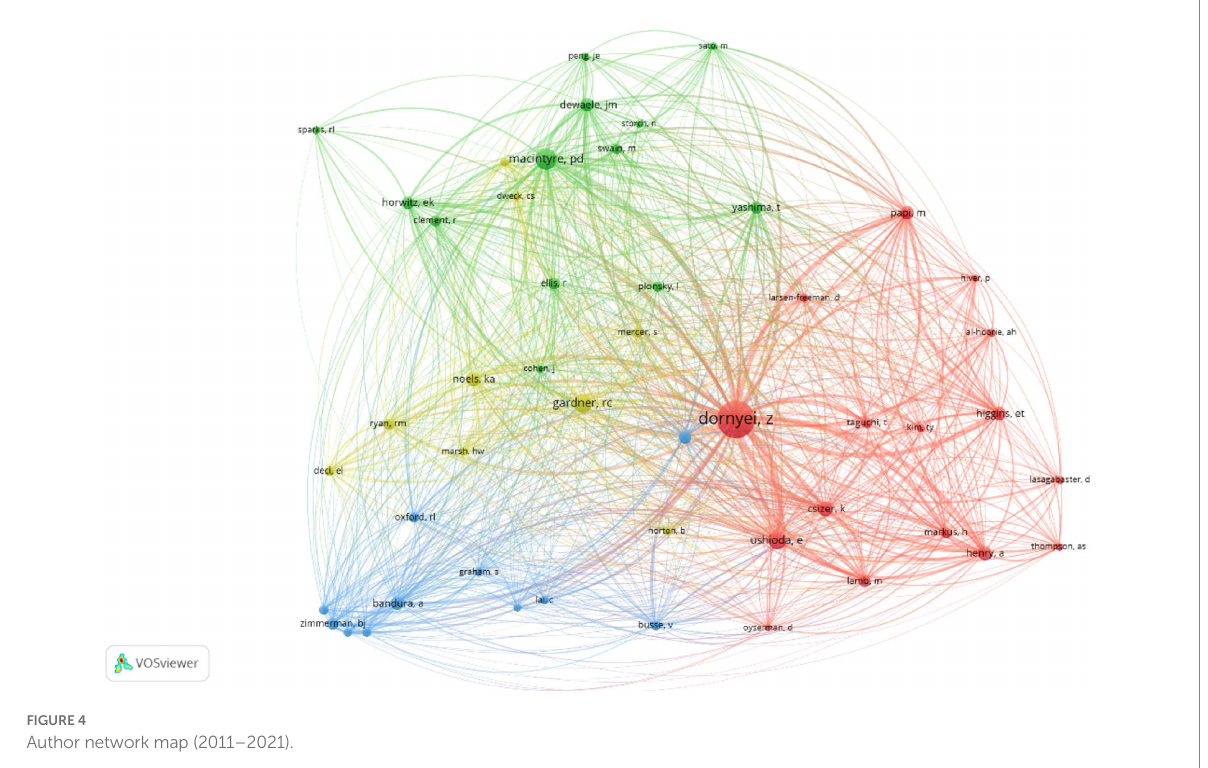
FIGURE 4 Author network map (2011–2021).